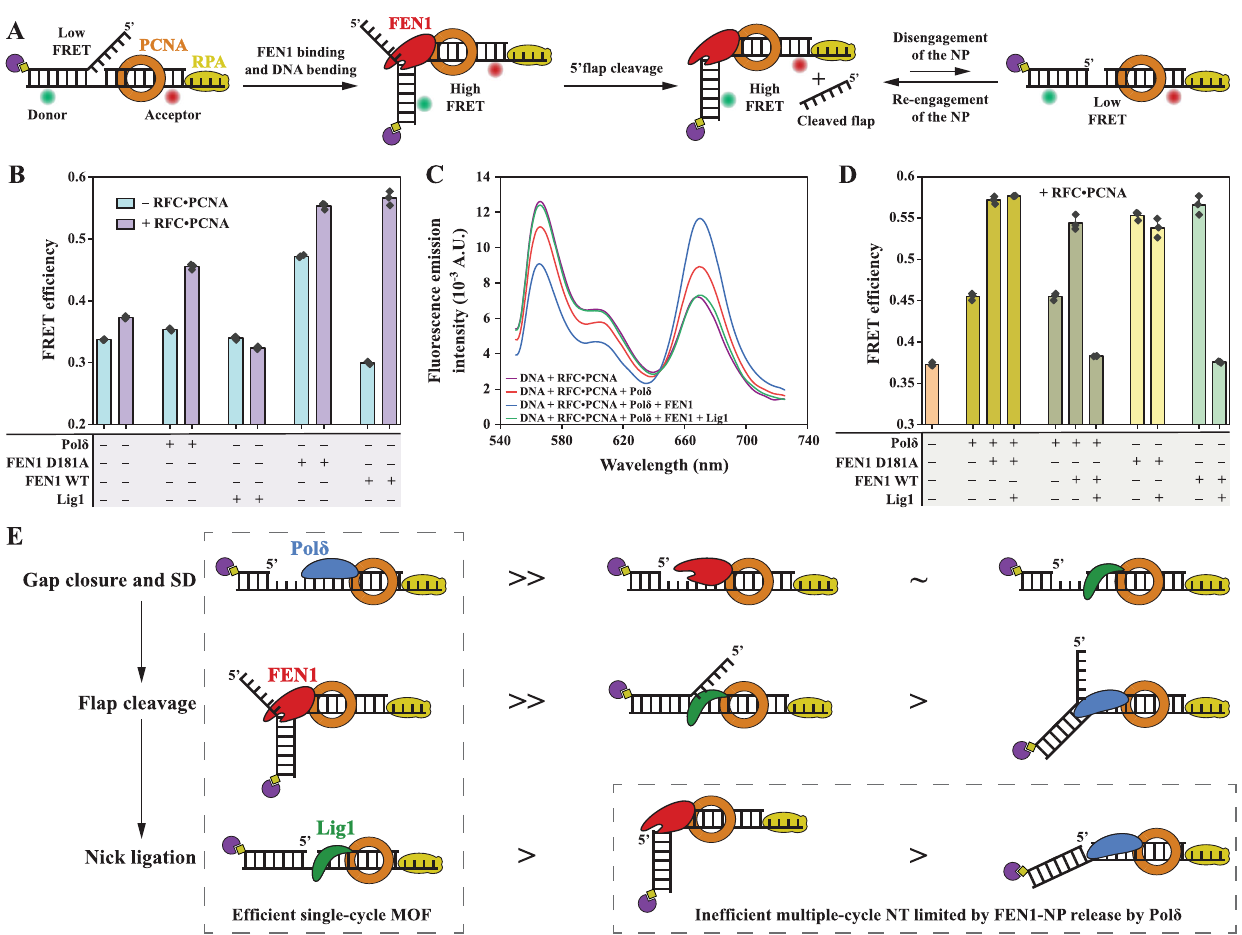
Fig. 2 | Substrate hand-offs among MOF proteins. A Cartoon representation of the internal-labeling schemeusedto monitor fl apand NP engagement. B Apparent FRET ef fi ciencies of the double fl ap (Sub#12; Supplementary Fig. 7) upon addition ofindividualMOFproteinsinthepresenceandabsenceofRFC • PCNA.Thebarchart illustrates the mean (as bar height) and one standard deviation (as error bar) of threeindependentmeasurements. C Examplesofemissionspectraoftheinternally labeled double fl ap (Sub#12) upon addition of various combinations of MOF pro- teins. D Apparent FRET ef fi ciencies of the internally labeled double fl ap (Sub#12)